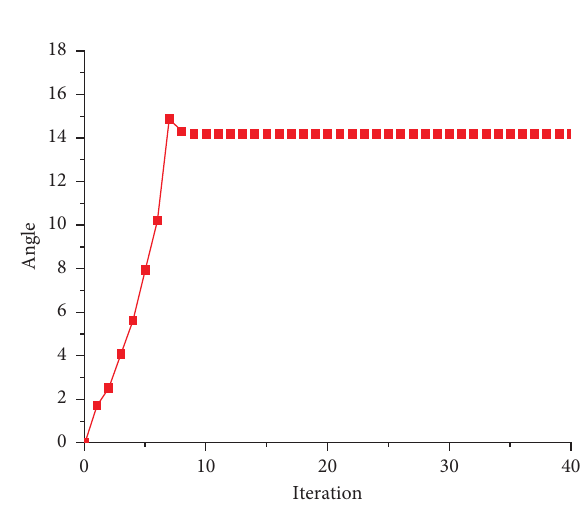
Figure 17: Cultural particle swarm curve.